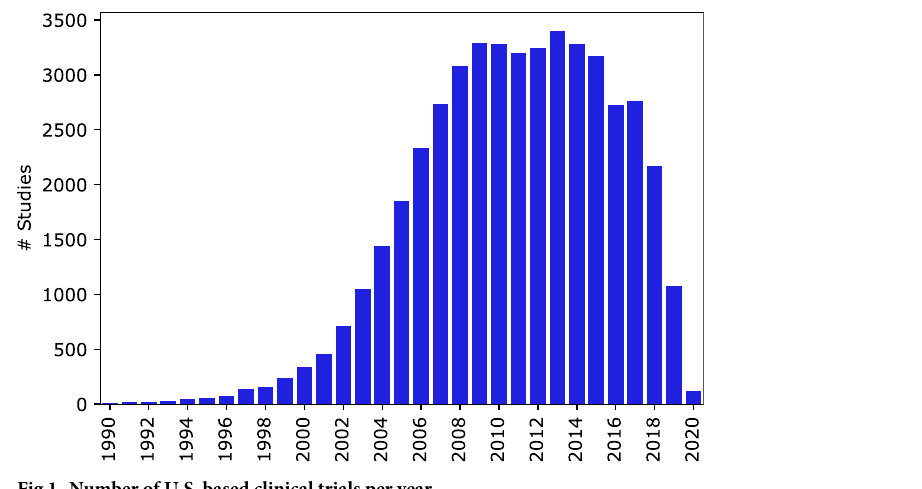
Fig 1. Number of U.S. based clinical trials per year.